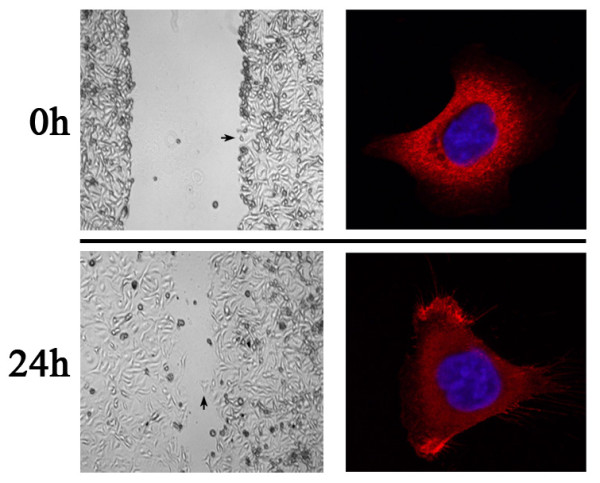
Immunofluorescence staining for Ezrin protein in cultured MKN-1 cells (red for Ezrin protein & blue for DAPI). Ezrin protein located in the cytoplasm and membrane in cultured MKN-1 migrating gastric cancer cells, and it mainly concentrated at the membranous protrusion site (Figure 1, 24 h); however, Ezrin protein only located at the cytoplasm of non-migrating cancer cells (Figure 1, 0 h).